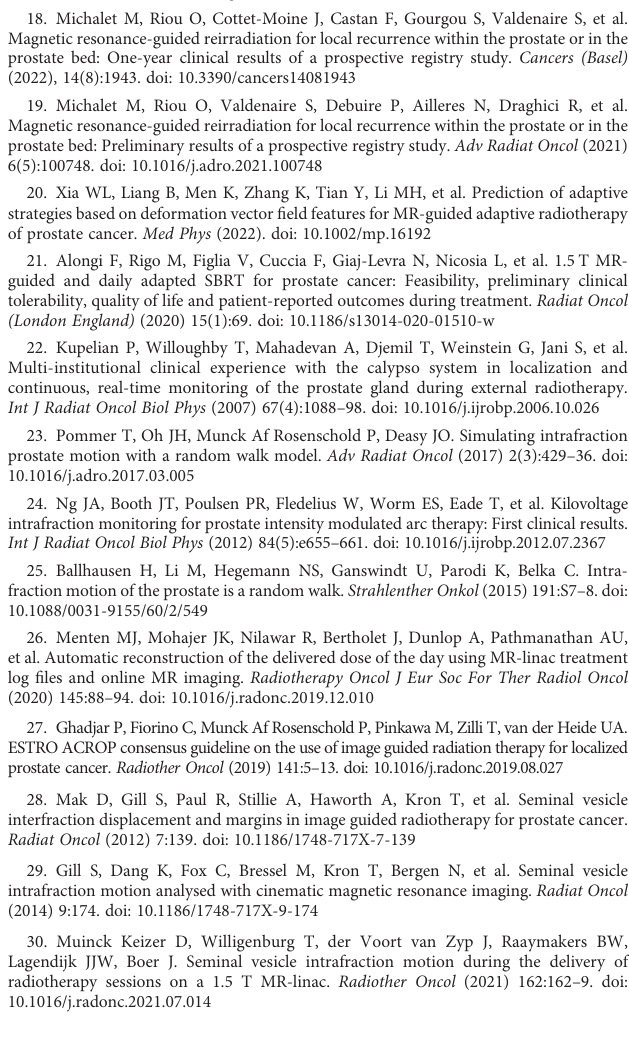
SUPPLEMENTARY FIGURE 1 Overviews of planning targets of all fractions, calculated by the daily ATS plan dose in PV-, Bn- and post-MR scans. 100% prescription dose (A) and 95%